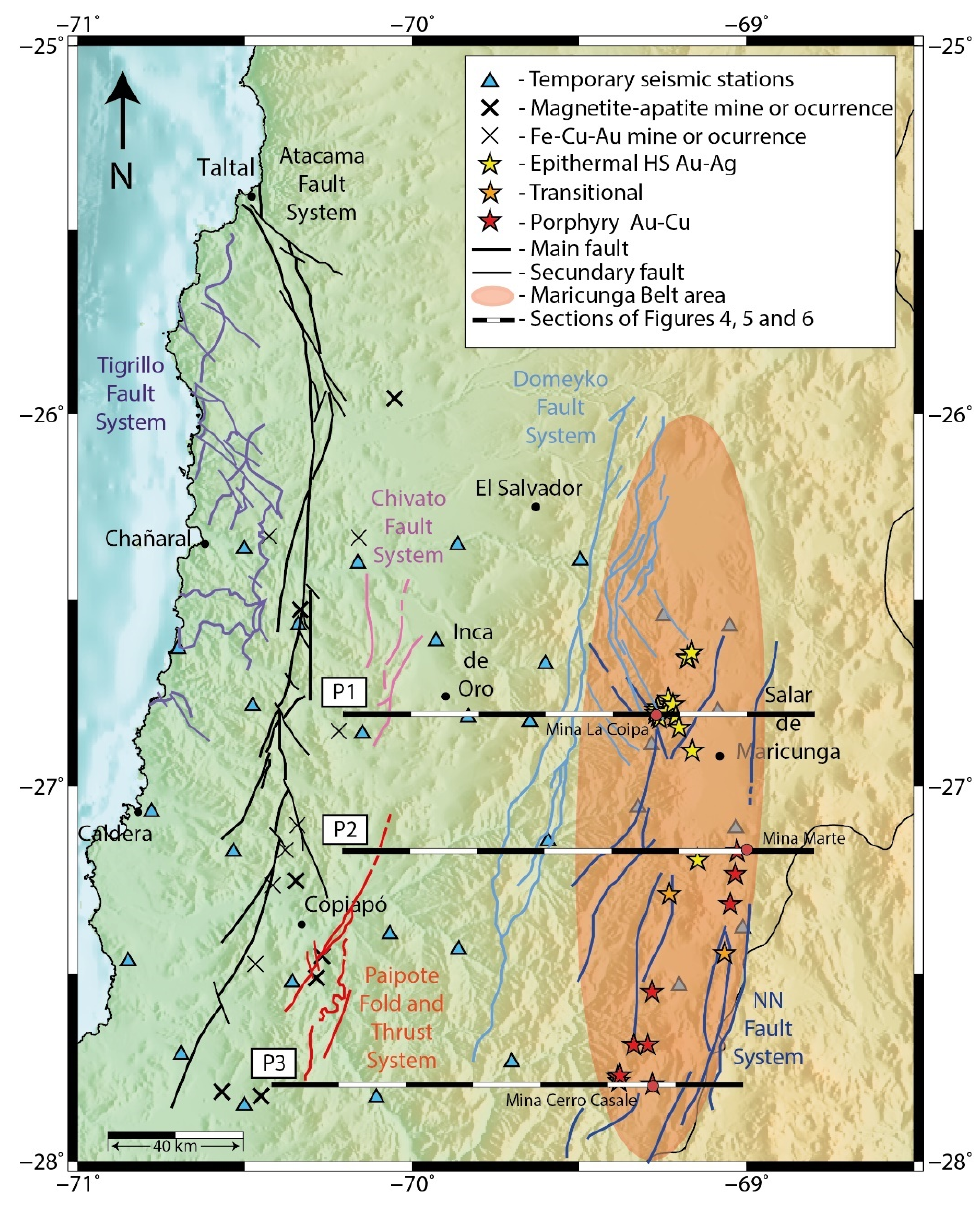
Figure 1. Overview map of the study area. The MB is represented by the red shadow area. Large regional mines and occurrences of magnetite-apatite and Fe oxide Cu-Au are indicated with light and dark crosses, respectively. Main regional-scale faults are indicated by purple (Tigrillo Fault System), black (Atacama Fault System), pink (Chivato Fault System), red (Paipote Fold and Thrust System), and light blue (Domeyko Fault System) lines (modified from [3]). The spatial distribution of gold deposits is indicated with yellow, orange, and red stars to represent high-sulphidation Au-Ag epithermal, transitional, and porphyry Au-Cu type deposits, respectively [2]. Selected local innominate (NN) fault systems are represented with blue lines (modified from [4]). Light-blue triangles indicate the temporary seismic network of the project developed between the research centers—the Advance Mining Technology Center (AMTC) of Chile and the Karlsruhe Institute of Technology of Germany in northern Chile [5,6]. Black-white lines outline the locations of the cross-sections through the 3-D velocity cube. Red dots refer to mines present in the same sections.